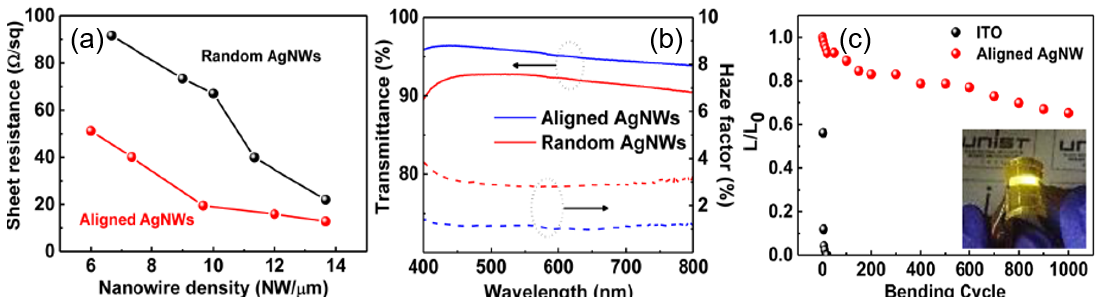
Figure 15. Optical and electrical properties of Ag NW networks with aligned and random orientation.